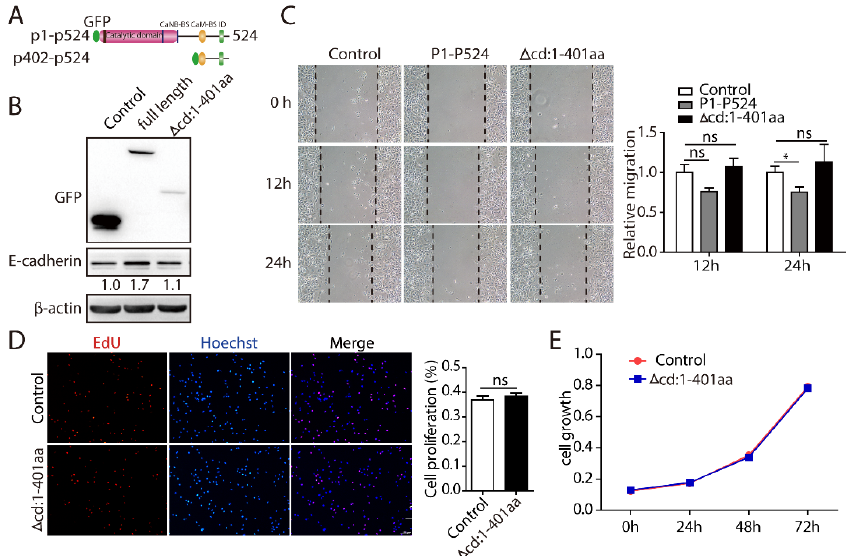
Figure 5. PPP3CB 1–401 containing the catalytic domain plays a critical role in EMT and cell proliferation. ( A ) PPP3CB structure and deletion (PPP3CB 402-524; ∆ cd:1–401 aa) ( B ) G401 cells infected with control, PPP3CB, and PPP3CB1–401 deletion, subjected to western blotting with indicated antibodies. ( C ) Cell migration of stable G401 cells with overexpression of PPP3CB or the PPP3CB1–401 deletion mutant assessed by wound healing at the indicated time points (0h, 12h, and 24 h). Data are presented as mean ± SEM from three independent experiments. * p < 0.05. ( D ) Growth of G401 stable cells were measured by EdU assay. Red represents EdU, blue stains nucleus, scale bar is 100 μm. Results are expressed as mean ± SEM from three replicate wells. ( E ) Proliferation of stable G401 cells were measured by MTT assay. Results were expressed as mean ± SEM from eight replicate wells.